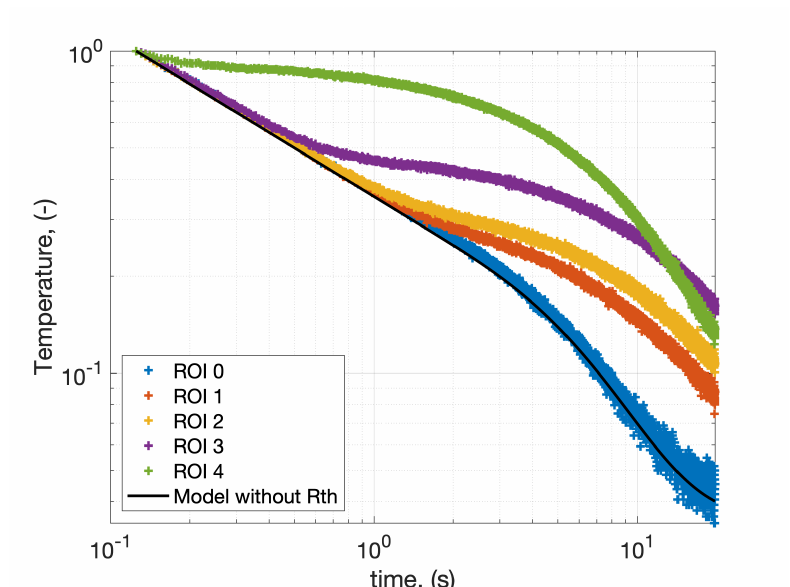
Figure 7. Loglog dimensionless temperature response of the front face to a pulse of 1 ms duration and adiabatic boundary conditions as a function of the thermal resistance for a sample composed of one layer of polycarbonate, one layer of thermal resistance and one aluminum layer.